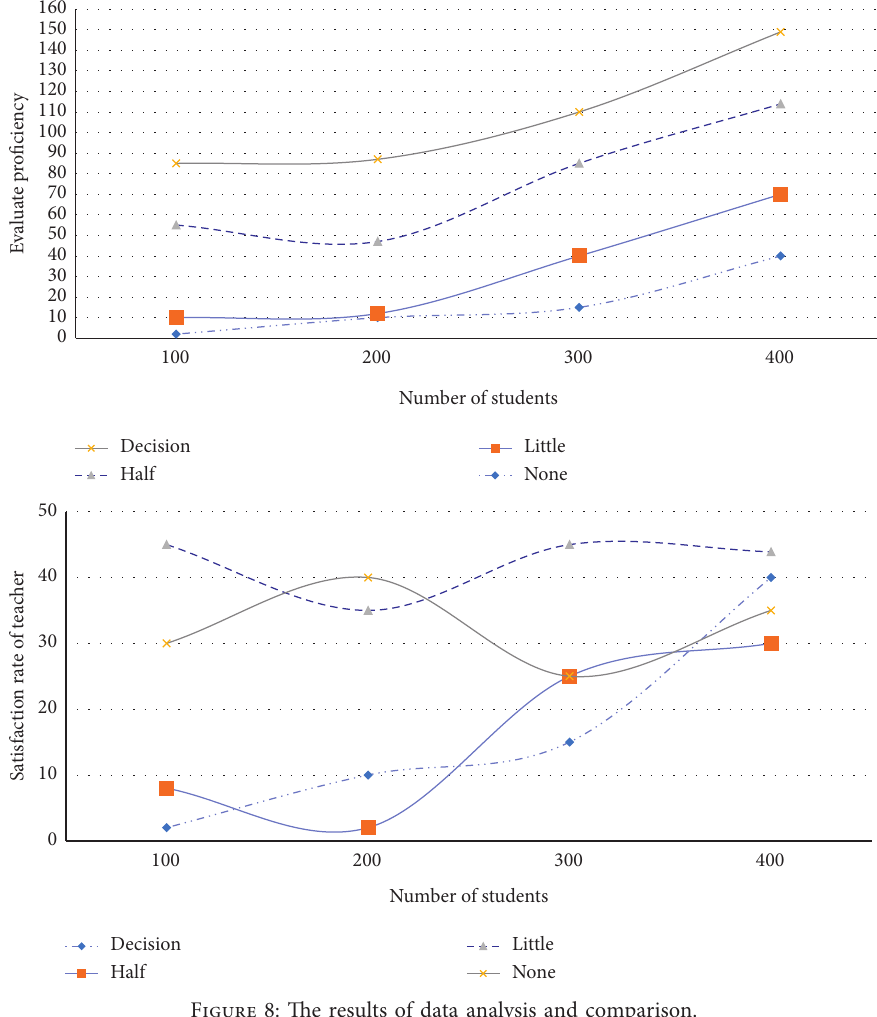
Figure 8: The results of data analysis and comparison.